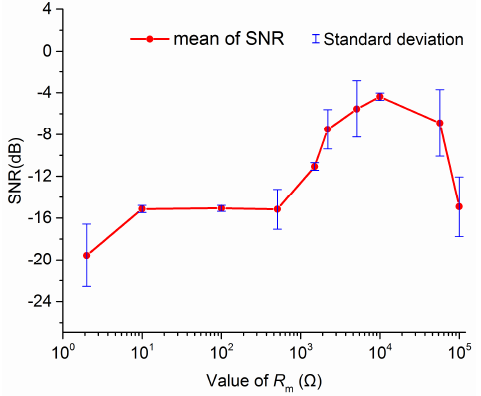
Figure 7. SNR of the FID signal with different value of R m ; Red dots represent the mean of SNR and the blue lines represent the standard deviation.